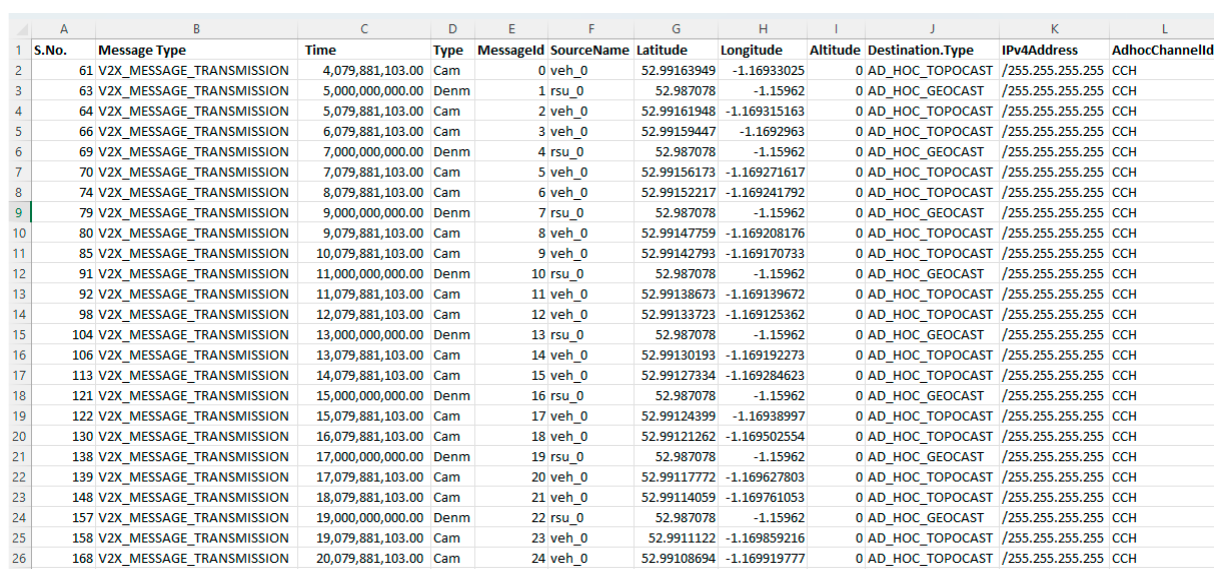
Figure 11. Message reception dataset sample.